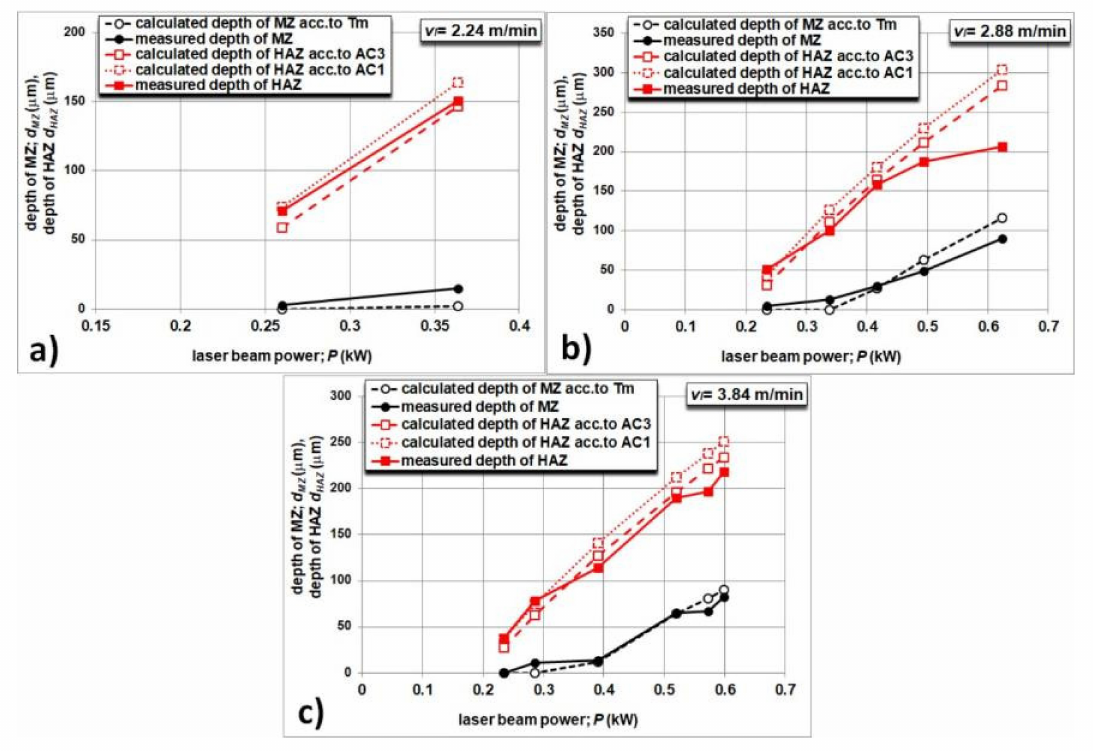
Figure 8. The e ff ect of laser beam power on the measured and calculated depths of MZ ( d MZ ) and HAZ ( d HAZ ) at scanning rate of: 2.24 m · min − 1 ( a ); 2.88 m · min − 1 ( b ); and 3.84 m · min − 1 ( c